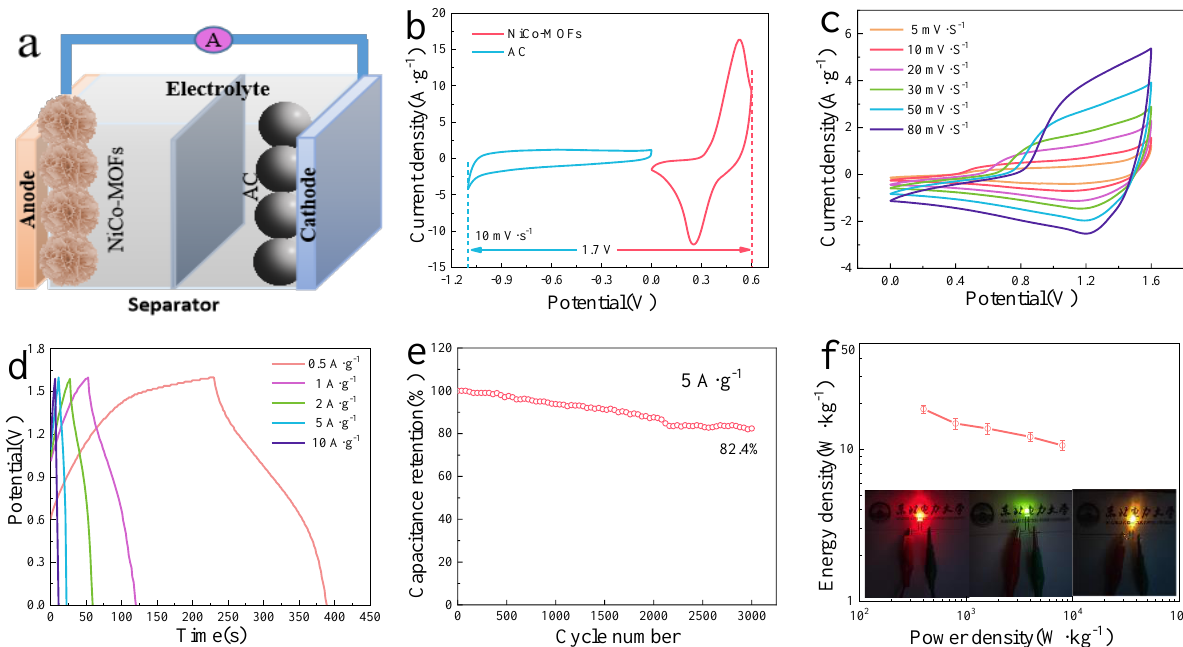
Figure 6. ( a ) Setting diagram of the NiCo − MOFs//AC HSCs; ( b ) CV curves of the NiCo− MOFs and AC at 10 mV·s −1 ; ( c ) CV curves of NiCo − MOFs//AC HSCs at 5−80 mV·s −1 ; ( d ) GCD curves of NiCo − MOFs//AC HSCs at 0.5−10 A·g −1 ; ( e ) Cycling life of the NiCo − MOFs//AC HSCs at 5 A·g −1 ; ( f ) Ragone plot of the NiCo − MOFs//AC HSCs and the lit LEDs was shown in the embedded diagram.